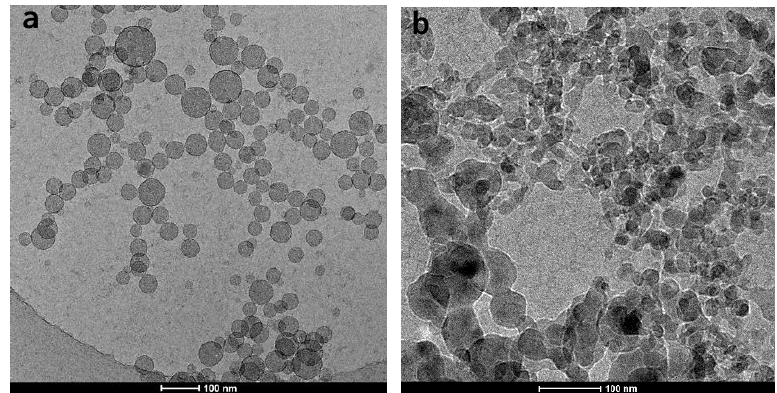
Figure 3. Cryo − electron microscope (cryo − TEM) observations of 6 mg/mL GPAM2 in 0.02 M HAc solution at ( a ) 10 °C and ( b ) 40 °C.